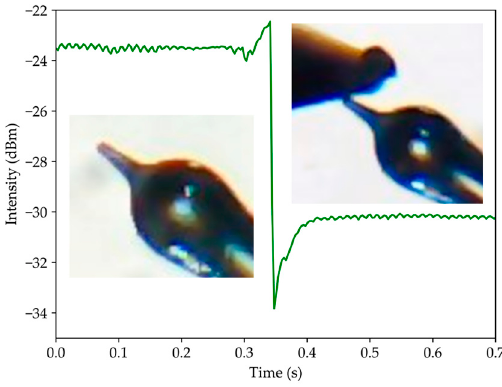
Figure 7. Sensor response when the tip is curved.